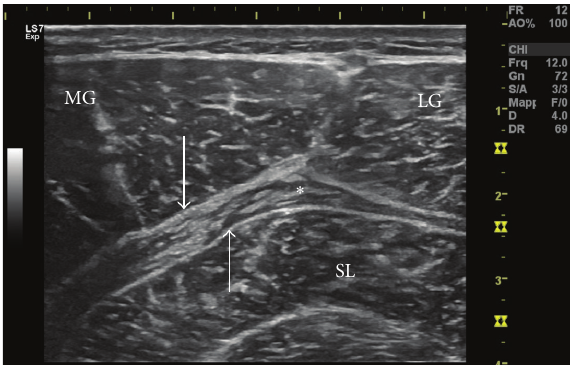
Figure 2: Isolated injury of the Crural Fascia, with considerable thickening of same ( asterisk ). Note the structural integrity of the medial gastrocnemius (MG) epimysium and of the soleus (SL), indicated by the arrows , and the absence of intramuscular edema. The muscle belly of the MG and Lateral Gastrocnemius (LG) are observable, a sign that the injury is not at muscle-tendon junction level.